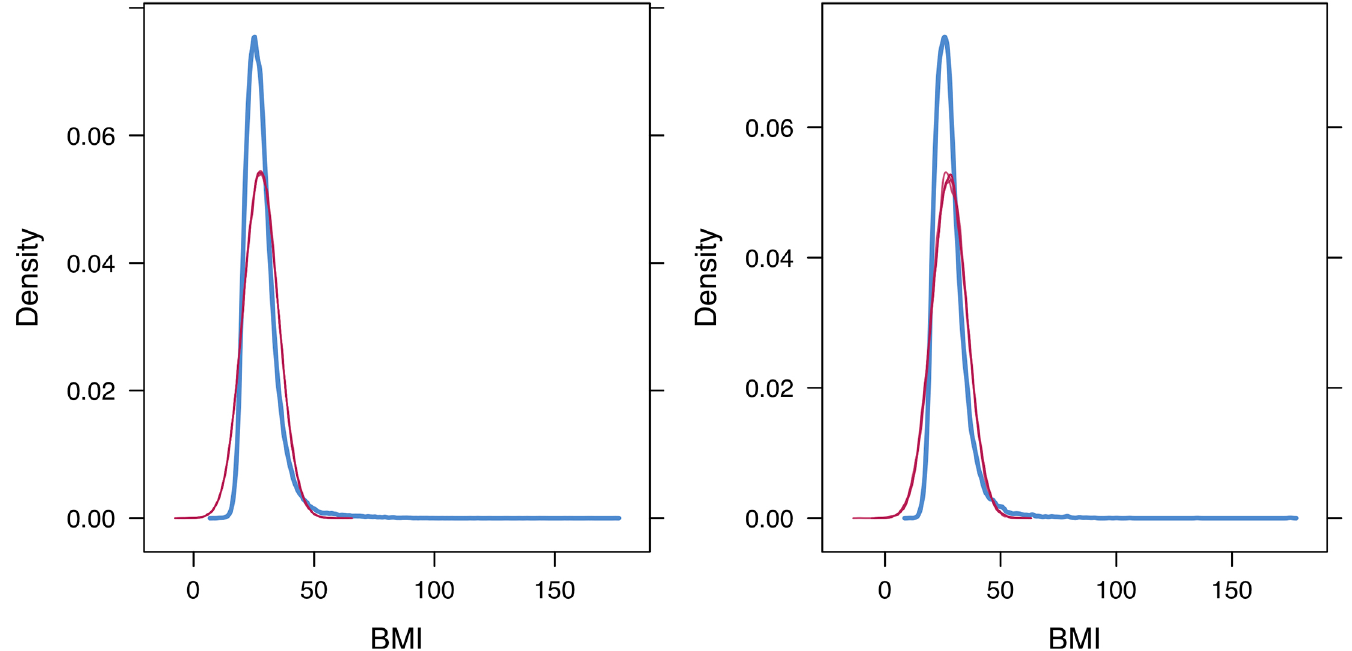
Appendix Figure 1: Kernel density estimates for the marginal distribution of the five imputed datasets (red) and the original data (blue) (left: development sets; right: validation sets)